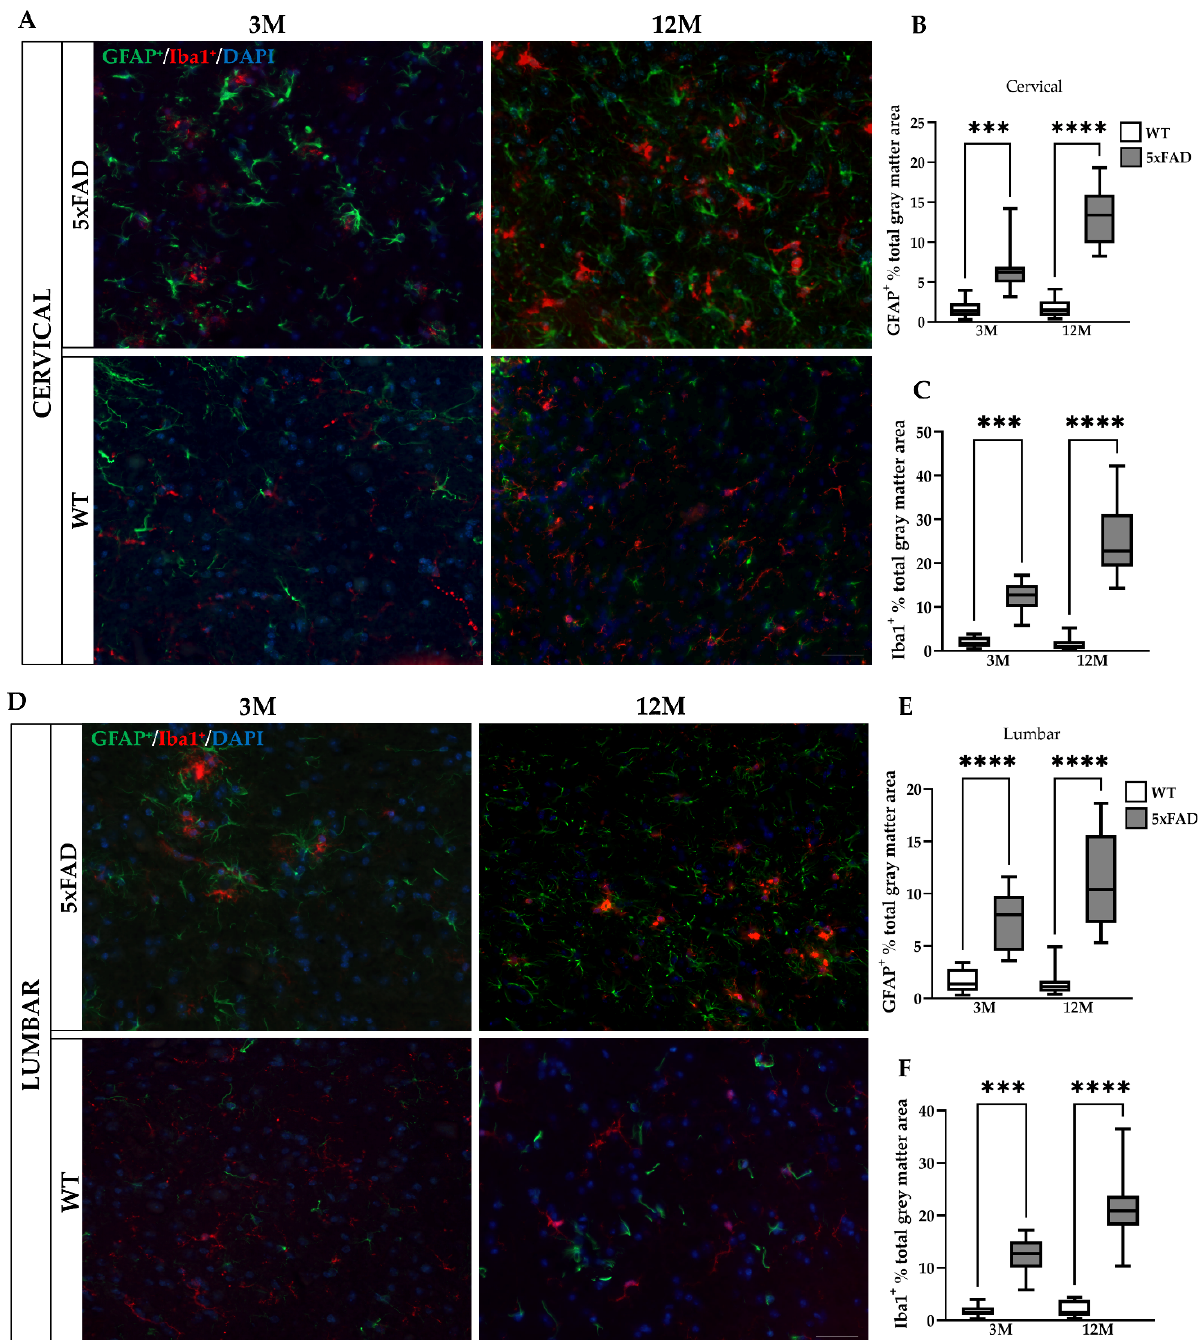
Figure 4. Severe astrogliosis and microglia activation in the spinal cord of 5xFAD mice. ( A ) In cervical C2 and ( D ) lumbar L2 spinal cord GM from 5xFAD and WT mice, double immunofluorescence staining was performed with astrocytic marker GFAP (green) and microglial marker Iba1 (red). 5xFAD mice showed intense astrogliosis in the spinal cord at 12 months of age and to a lesser degree also at 3 months, whereas WT mice of both ages showed no astrogliosis. Quantification of the percentage of the total GM area stained by GFAP + reactive astrocytes ( B , E ) and Iba1 + activated microglia ( C , F ) at both spinal cord levels displayed significantly increased immunoreactivity, which confirmed progressive neuroinflammation in 5xFAD mice. The statistical analysis was performed by one-way ANOVA followed by Kruskal–Wallis multiple comparisons test ( n = 6 for all genotype and age groups). Data are presented as mean ± SD. Scale bars = 50 µm in ( A , D ). Significance is given as: *** p < 0.001, **** p < 0.0001.